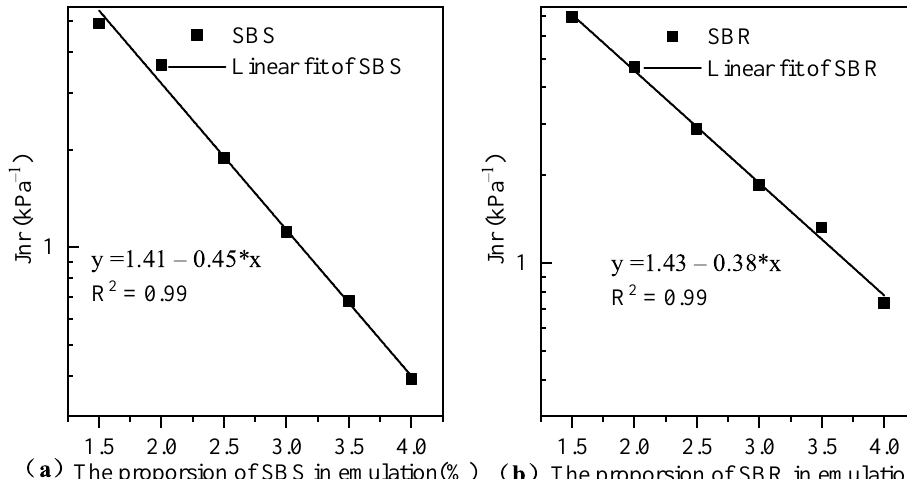
Figure 9. Variation of J nr with the content of SBS/SBR in emulsified